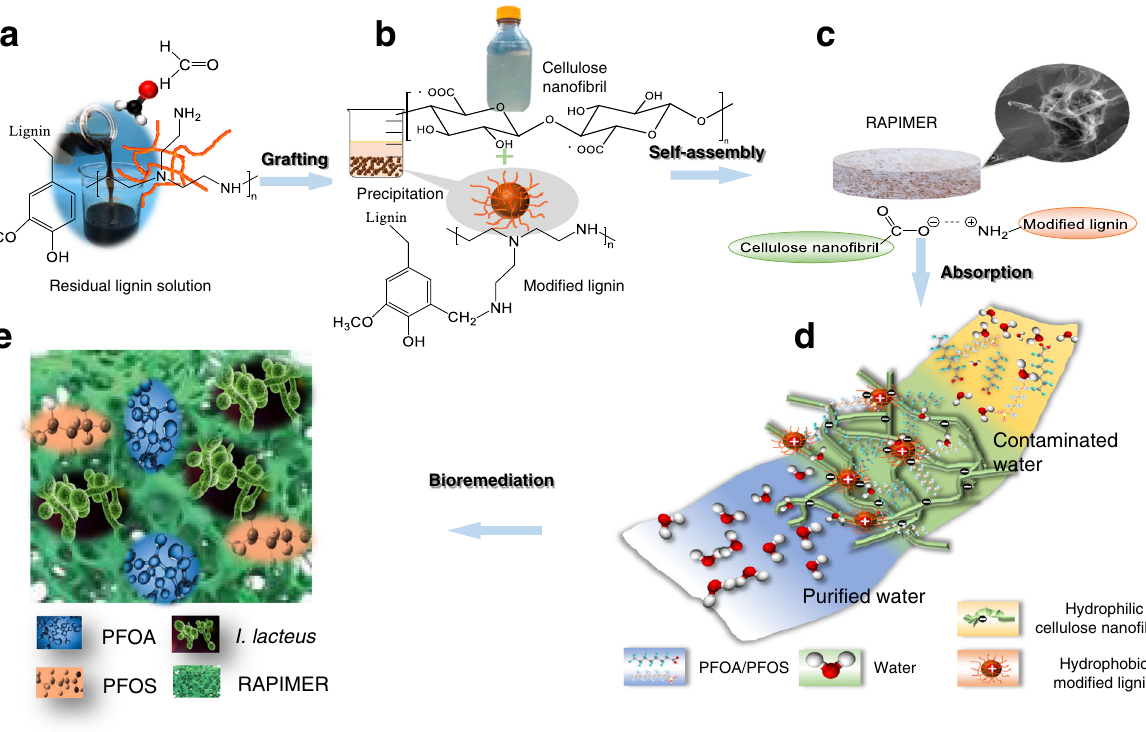
Fig. 1 The design strategy, fabrication process, chemical adsorption, and fungus degradation scheme of the RAPIMER system. a Corn stover residual lignin solution and selective graft reaction using formaldehyde and polyethylenimine to produce positively charged modi fi ed lignin particles. b Corn stover derived cellulose nano fi brils prepared by TEMPO-oxidation method and modi fi ed lignin chemical structure. c The modi fi ed lignin and nanocellulose nano fi brils formed RAPIMER composite through self-assembly by the formation of carboxylic acid/amine interaction. d PFAS adsorption by the RAPIMER composite. e Fungal bioremediation through co-metabolism and biodegradation of PFAS and RAPIMER